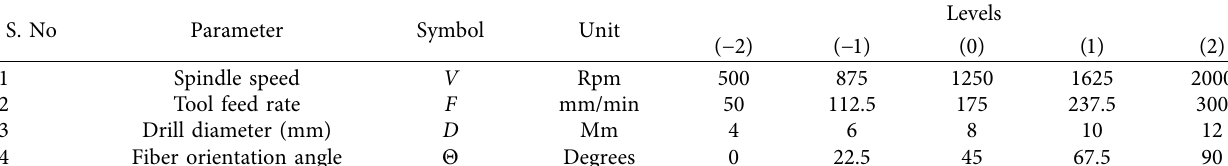
Table 2: Parameters in drilling experiments.